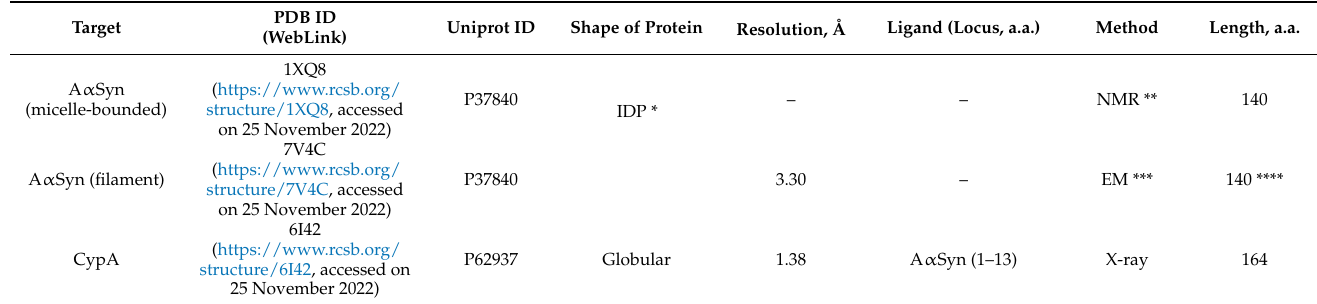
Table 6. Structures of A α Syn and CypA used for molecular docking with Anle138b